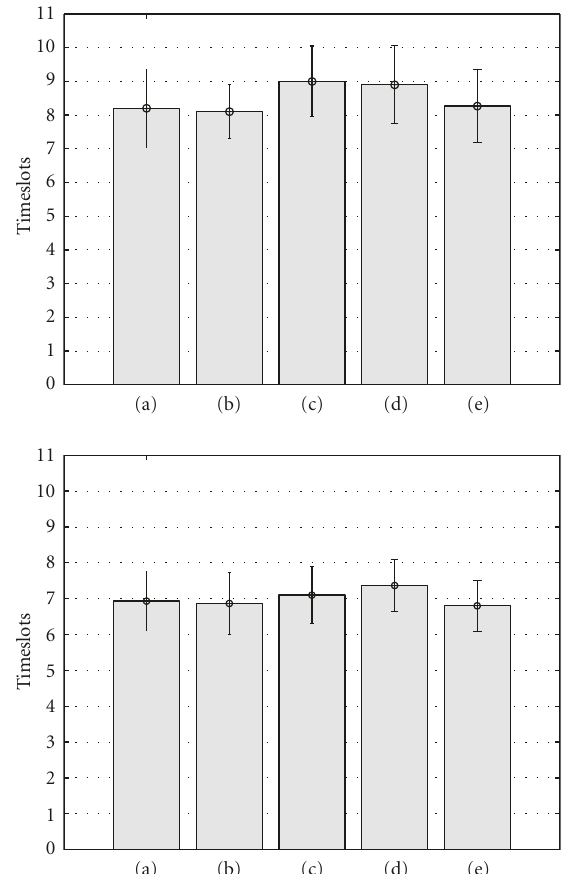
Figure 5: Required number of timeslots for optimal scheduling in the case of top 60 nodes and bottom 40 nodes: (a) minimum power routing (MPR), (b) interference aware pruning routing (IAPR), (c) minimum neighbors routing (MNR), (d) interference routing (IR), and (e) weighted power and interference routing (WPIR). Table 1: Performance of the routing schemes in WMN topologies with varying number of nodes.